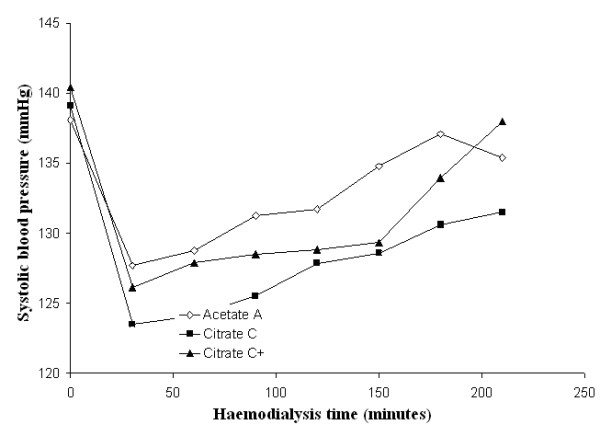
Systolic blood pressure. Systolic blood pressure as a function of the haemodialysis time using, respectively, acetate (A) (empty diamonds), calcium uncorrected citrate (C) (black squares) and calcium supplemented citrate dialysate (C+) (black triangles).